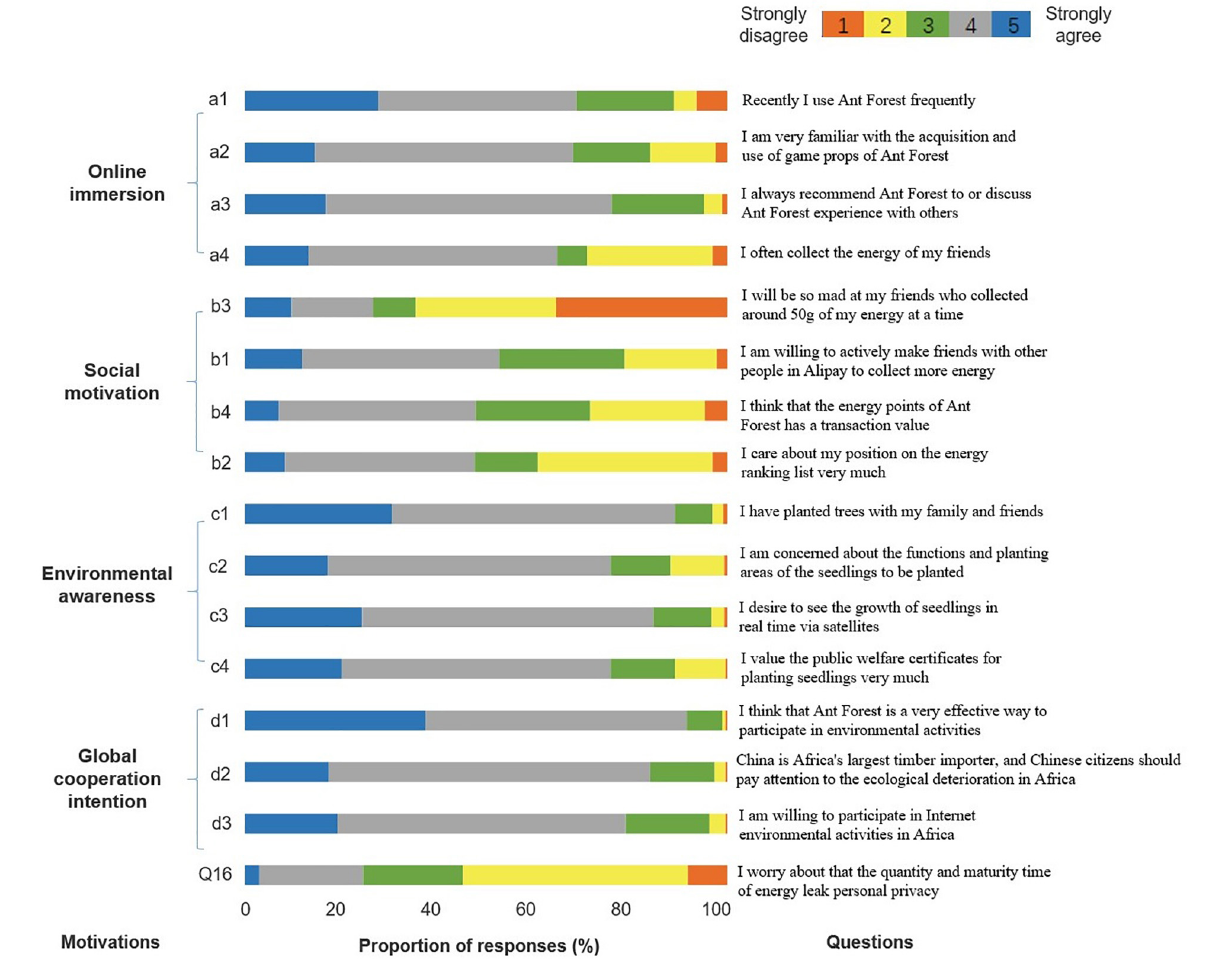
FIGURE 1 | Each motivation was assessed with three to four items including online immersion (a1–a4), social motivation (b1–b4), environmental awareness (c1–c4), and global cooperation intention (d1–d3). Q16 was eliminated by exploratory analysis. For each item, participants indicated their level of agreement from 1 ( strongly disagree ) to 5 ( strongly agree